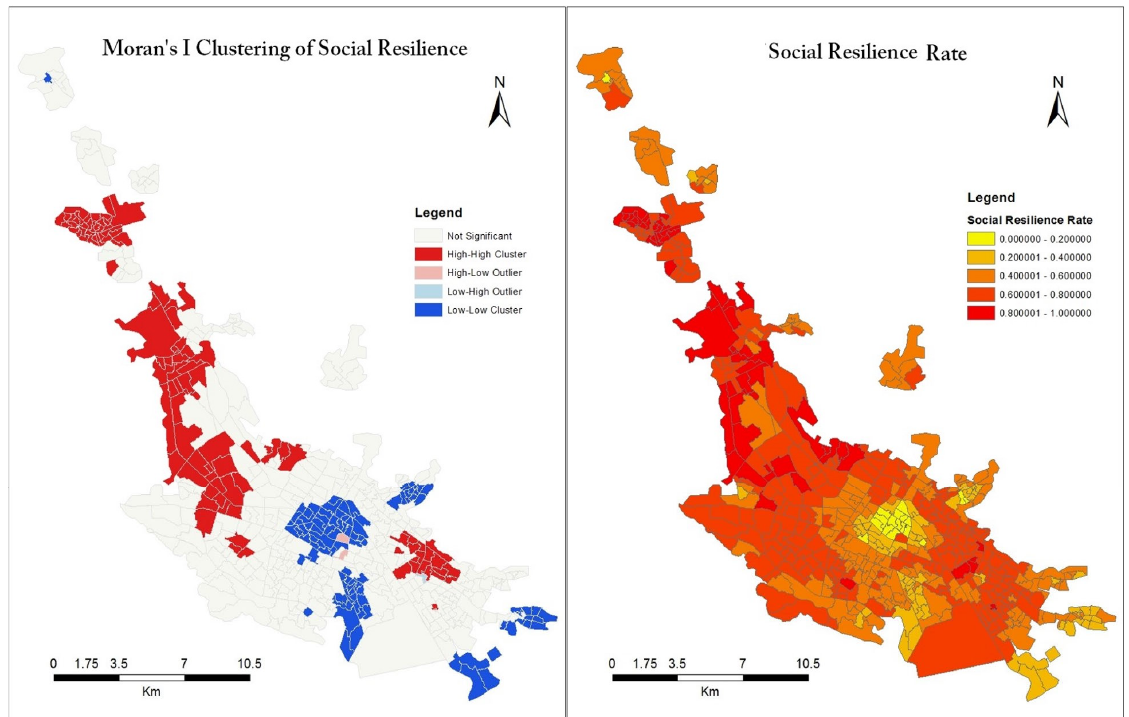
Figure 4 Social resilience value distribution in the case of Shiraz. Figure 4. Social resilience value distribution in the case of